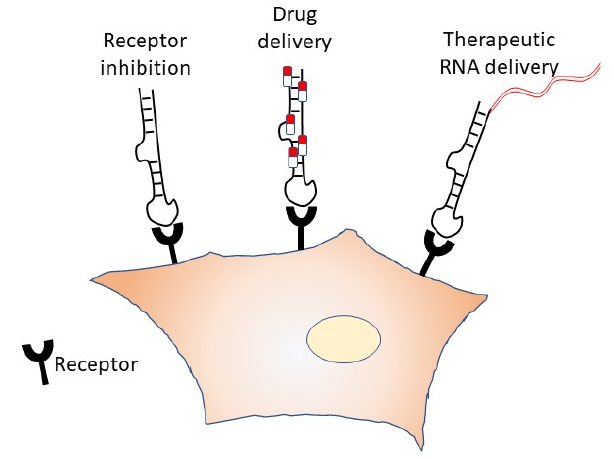
Figure 3. Schematic representation of aptamers engineering on receptor inhibition, drug delivery, and therapeutic RNA vehiculation.